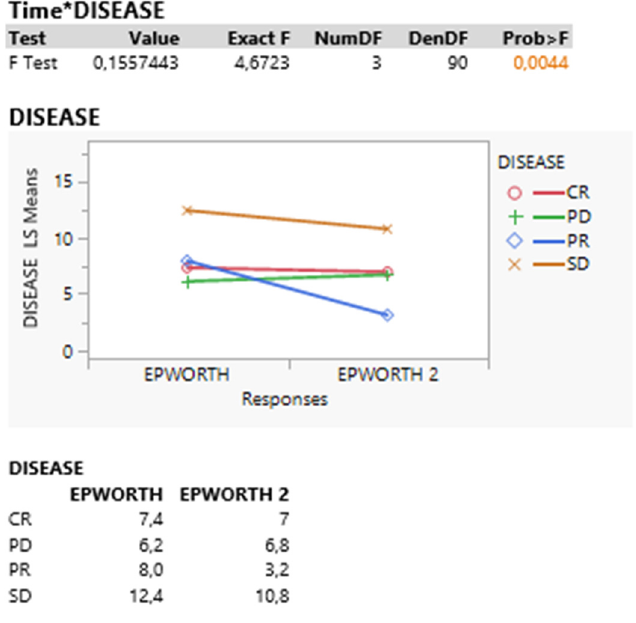
Figure 2. Time*disease interaction signals a significant effect ( p = 0.004). effect on Epworth responses ( p = 0.464), Figure 3.